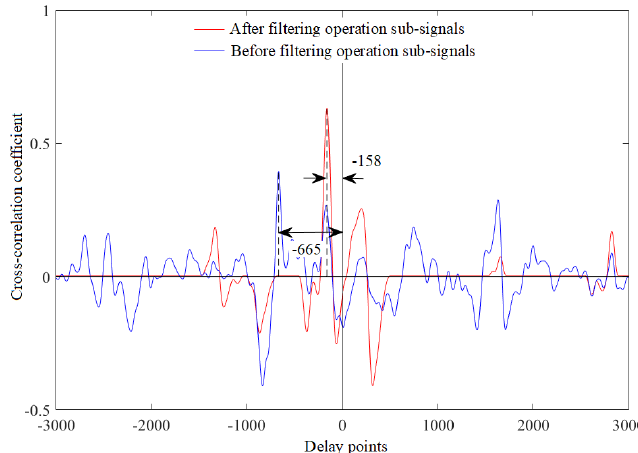
Figure 15. Cross-correlation curves before and after filtering operation